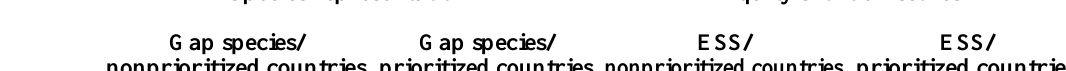
Table 1. Number species/country identified by the Global Gap assessment for nonprioritized and prioritized countries. Significant differences between nonprioritized and prioritized countries are indicated by * for P < 0.1 and ** for P < 0.01 (Wilcoxon rank-sum